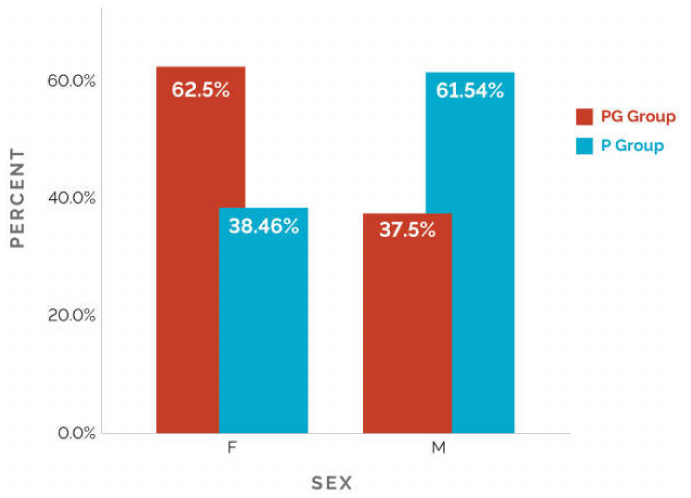
Figure 1. Sex dispersion in both